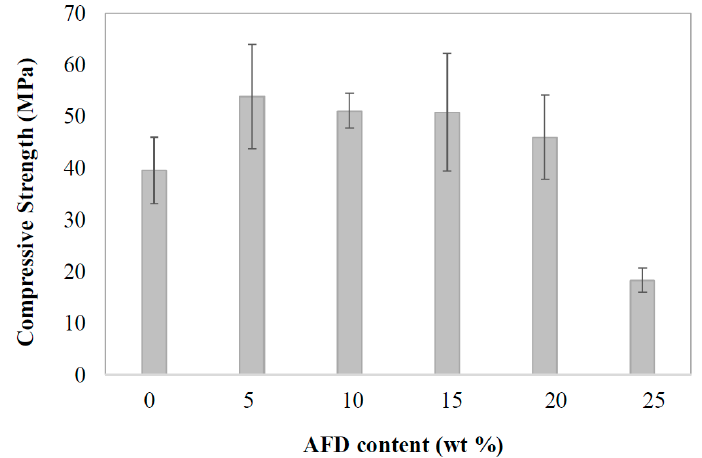
Figure 8. Compressive strength of fired bricks as a function of AFD waste content.